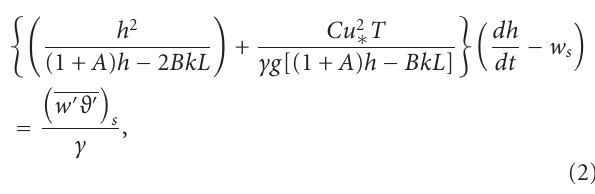
Figure 3: The natural logarithm of the RCS at 532 nm (parallel polarization). The higher the ln (RCS), the larger the aerosol cross- section. This can be due to larger particles (i.e., cloud droplets or rain) as well as higher numerical particle concentration. Gray and white bars represent the top of aerosol stratifications. The PBL height can be assigned to one of these aerosol layers. The length of the lines represent their